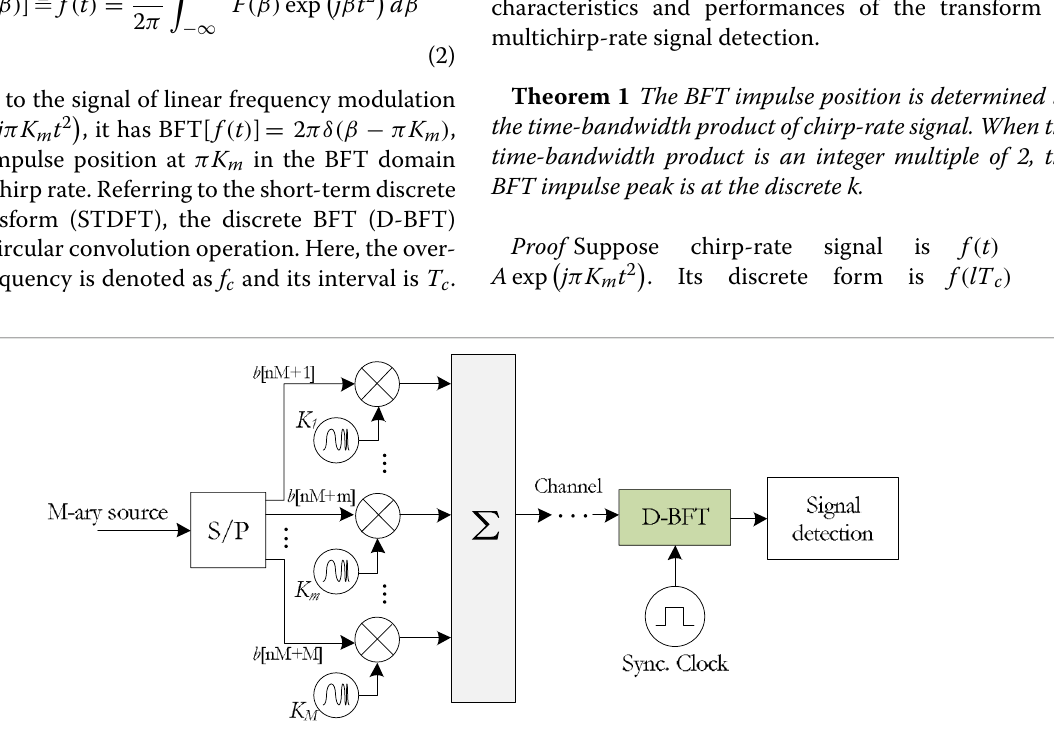
Fig. 1 M-ary chirp-rate signal and D-BFT demodulation. The figure shows the system block diagram for the multichirp-rate modulation and BFT